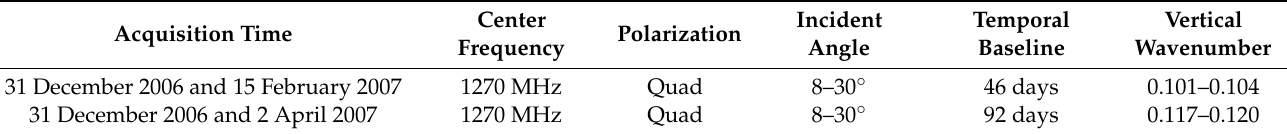
Table 1. Parameters of ALOS-1 data applied in this